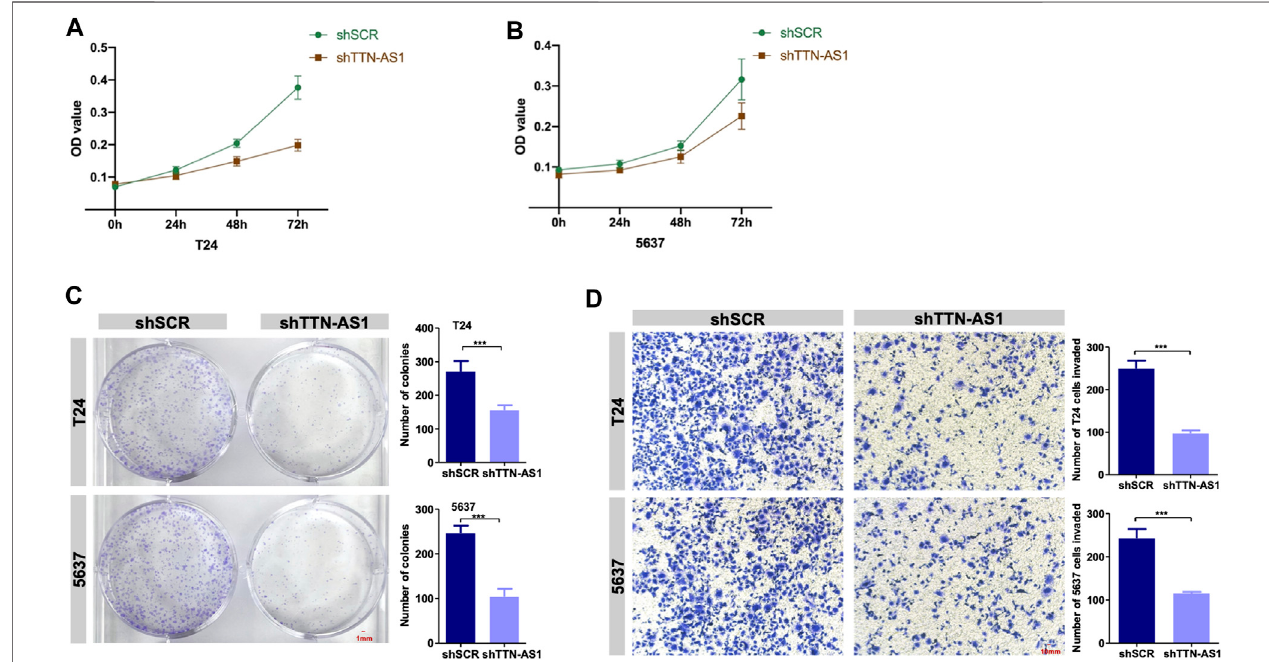
FIGURE2| Knockdown oflncRNA TTN-AS1 inhibitsthe proliferation and invasion ofBCcells invitro . (A,B) The MTTassay wasused toexplore theproliferationof twoBCcelllines(T24and5,637)aftertheknockdownoflncRNATTN-AS1.Theabsorbancevaluewasdetectedatawavelengthof490 nm(*means: p < 0.05,**means: p < 0.01) (C) Colonyformationassayswasconducted todetected theabilitiesofproliferationintwoBCcell lines(T24 and5,637)after knockingdown lncRNATTN-AS1 andthenumberofcolonieswascountedandplottedonagraph(***means: p < 0.001). (D) Transwellinvasionassayswereconductedtodetecttheinvasivenessof the BC cell lines (T24 and 5,637) after knockdown of lncRNA TTN-AS1, and the number of invaded cells was counted and plotted on a graph (*** means: p < 0.001).